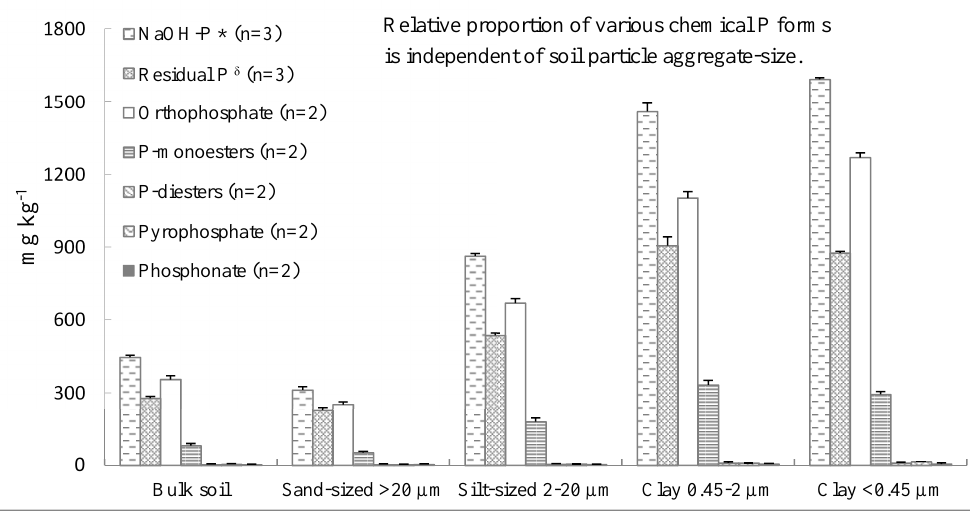
Figure 3. NaOH–Na 2 EDTA-extractable P, residual P content, and phosphorus forms/contents (mgkg − 1 ) from the NaOH–Na 2 EDTA extracts in different aggregate-sized fractions as identified by solution phosphorus-31 nuclear magnetic resonance spectroscopy. The varying chemical P contents were determined by multiplying the proportion of spectral area by the total concentration of the NaOH–Na 2 EDTA-extractable